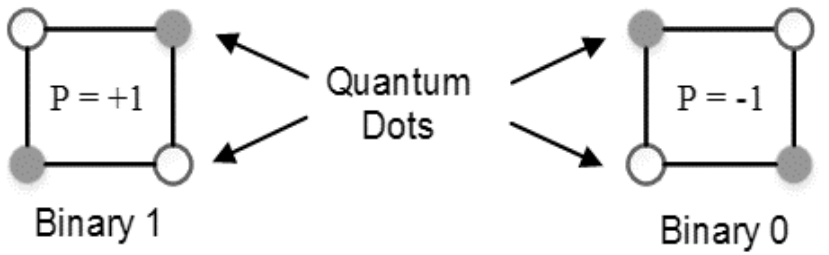
Figure 1. Representation of polarization states of QCA cell [7,8] .